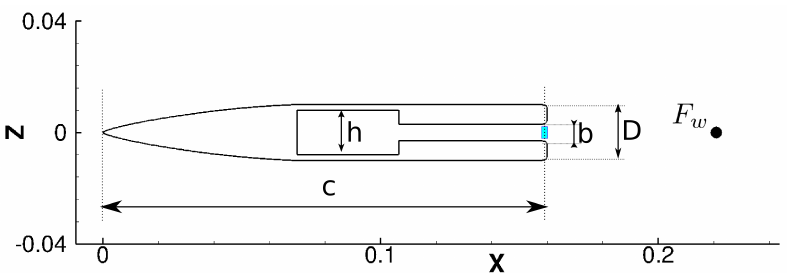
Figure 8. Main dimensions of the model and location of numerical probes for flow monitoring. Regions for jet flow analysis are highlighted in blue, and the location of the wake analysis probe is named F w .